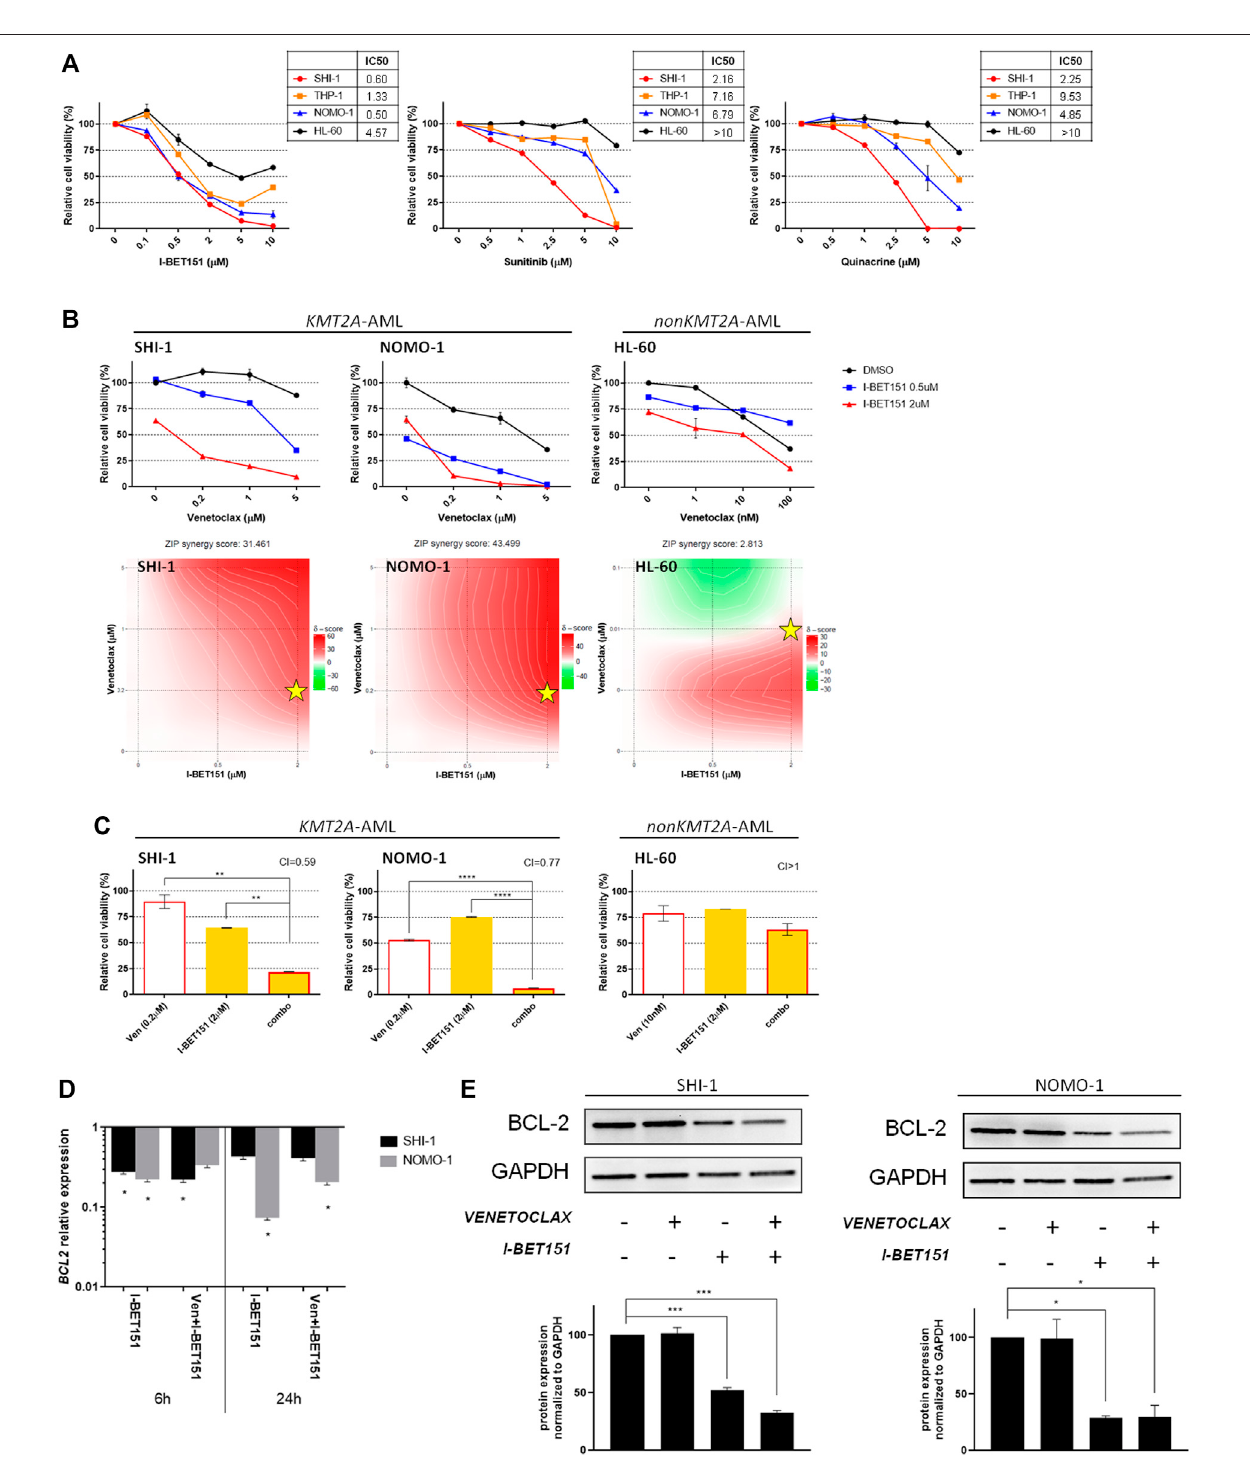
FIGURE 2 | Combination of venetoclax and I-BET151. ( A ) Dose – response curve of growing concentrations of I-BET151, sunitinib, and quinacrine in KMT2A- rearrangedacutemyeloidleukemia(AML;SHI-1,THP-1,andNOMO-1)andnon-KMT2A-rearrangedAML(HL-60)celllinesat72 haftertreatment( n =2).( B )Cellviability of SHI-1 and NOMO-1 (KMT2A-rearranged) or HL-60 (non-KMT2A-rearranged) after treatment with I-BET151 combined with venetoclax at 48 h after treatment. The synergyscoreswererepresentedbypseudocoloring2-dimensionalcontourplotsoverthedosematrix(redindicatessynergyandgreenindicatesantagonism)and calculatedusingtheZIPmodel(synergywhen > 10, n =2).Starsindicatetheconcentrationsselectedforsubsequentexperiments.( C )CellviabilityofSHI-1andNOMO-1 (KMT2A-rearranged) or HL-60 (non-KMT2A-rearranged) after treatment with venetoclax, I-BET151, or the combination at 48 h after treatment (CI, combination